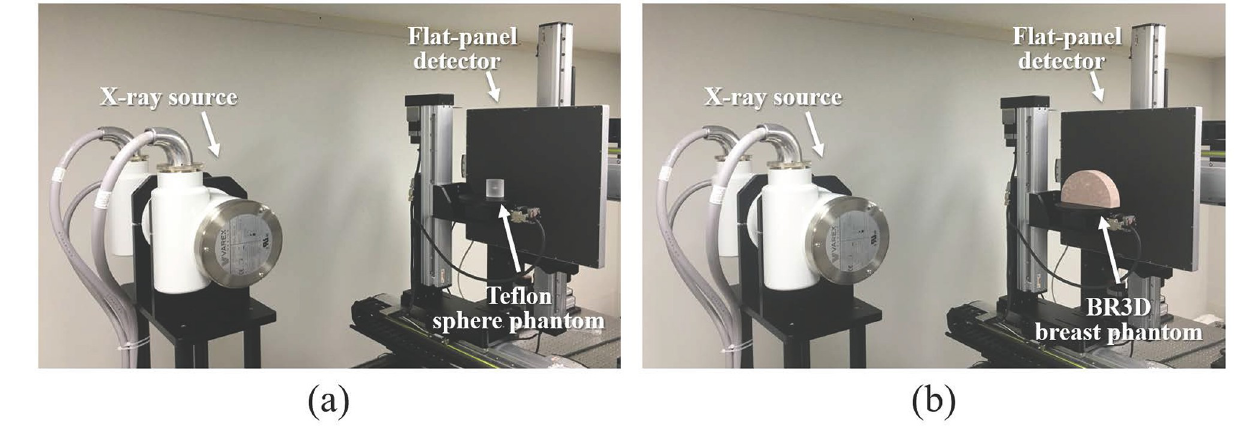
Fig 2. The table-top experimental system. (a) a Teflon sphere phantom and (b) a BR3D breast phantom.